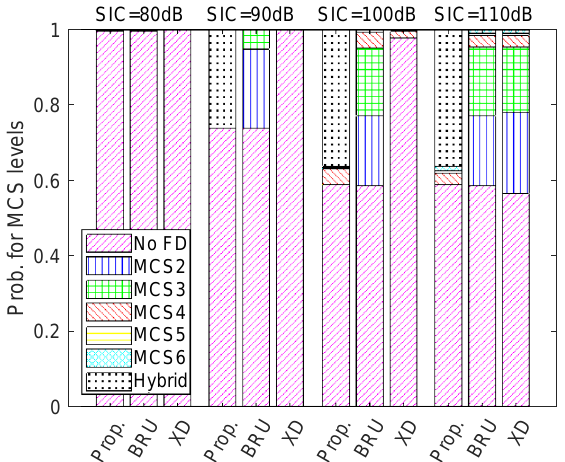
Figure 9. MCS level